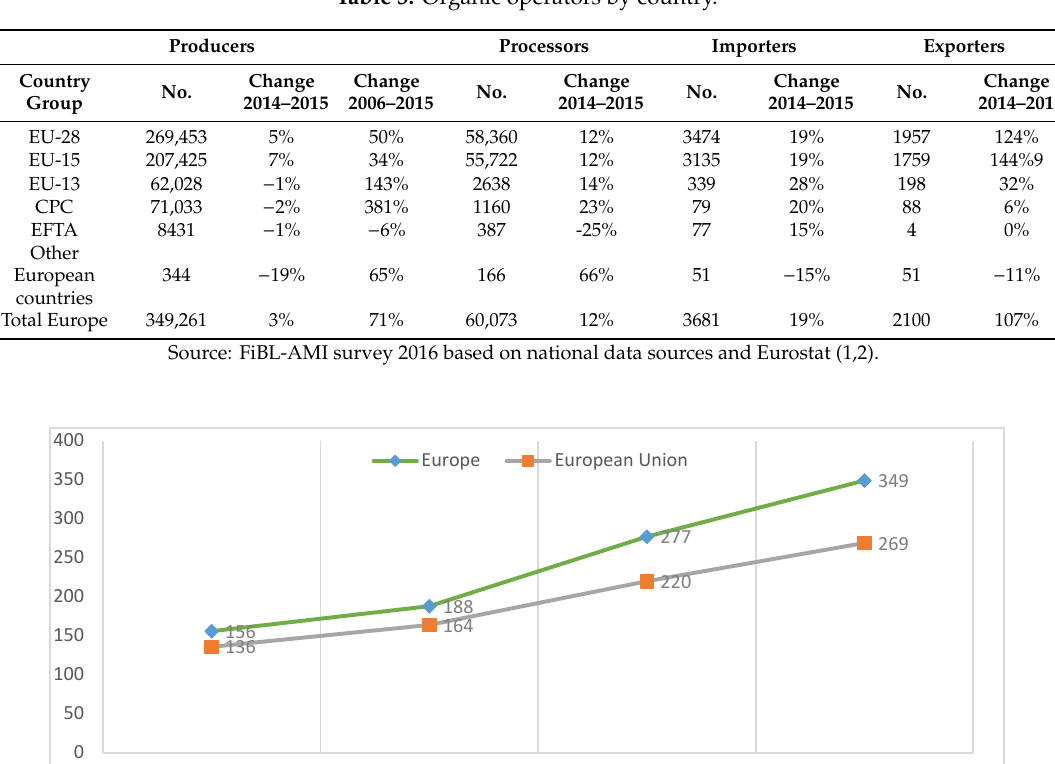
Table 3. Organic operators by country.